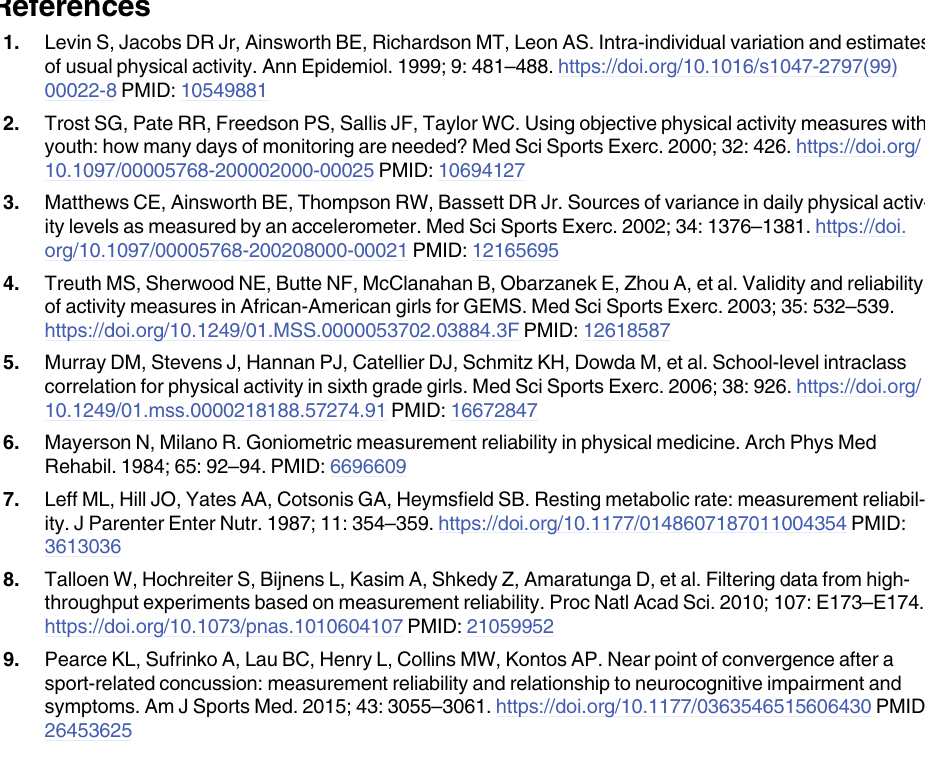
S3 Fig. Direct estimation of aggregate reliability in sensitivity analysis. Results of the inves- tigation into aggregate reliability of the average daily activity for each activity metric, estimated as the test-retest reliability (intraclass correlation) of the averages from two separate periods of between 2 and 10 days selected for each participant. This can be compared to Fig 4 in the main